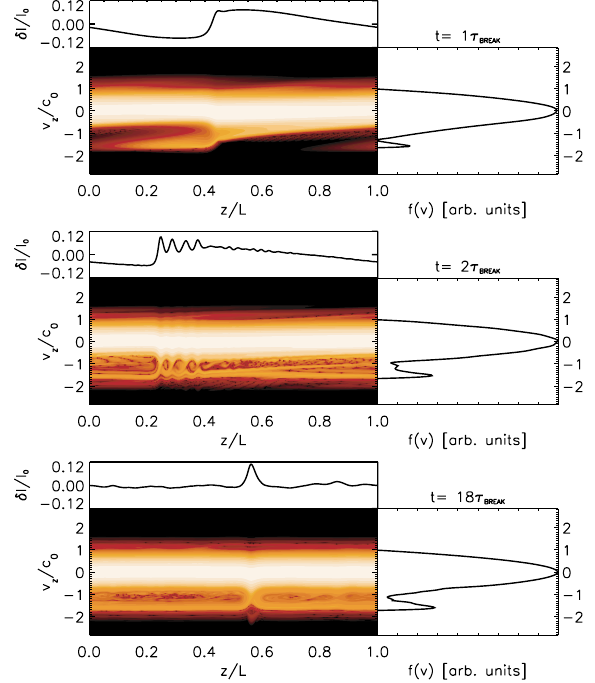
FIG. 4. (Color) Contour plots of the distribution function ln f (cid:2) z , y z (cid:3) together with the corresponding line density r L and the velocity distribution ln f (cid:2) y z (cid:3) obtained from the Vlasov simulation by starting with a current modulation at n (cid:2) 1 and U sc (cid:2) 10